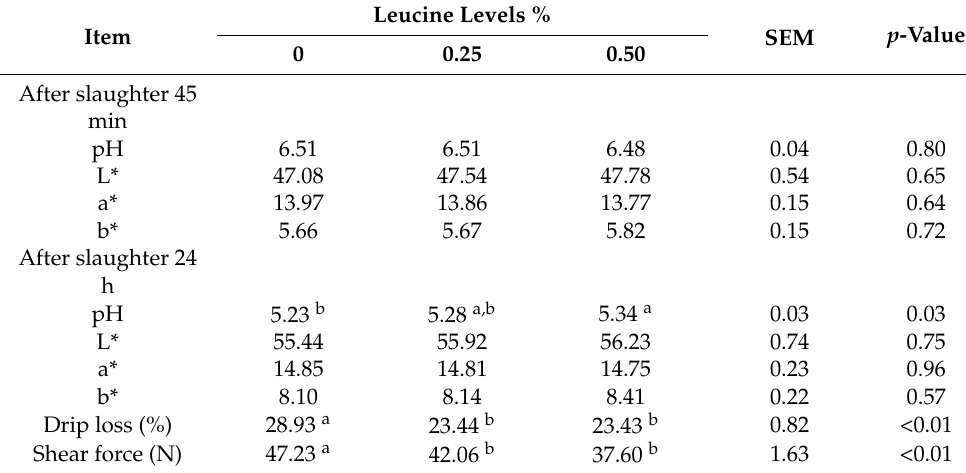
Table 5. Effects of dietary leucine on meat quality of finishing